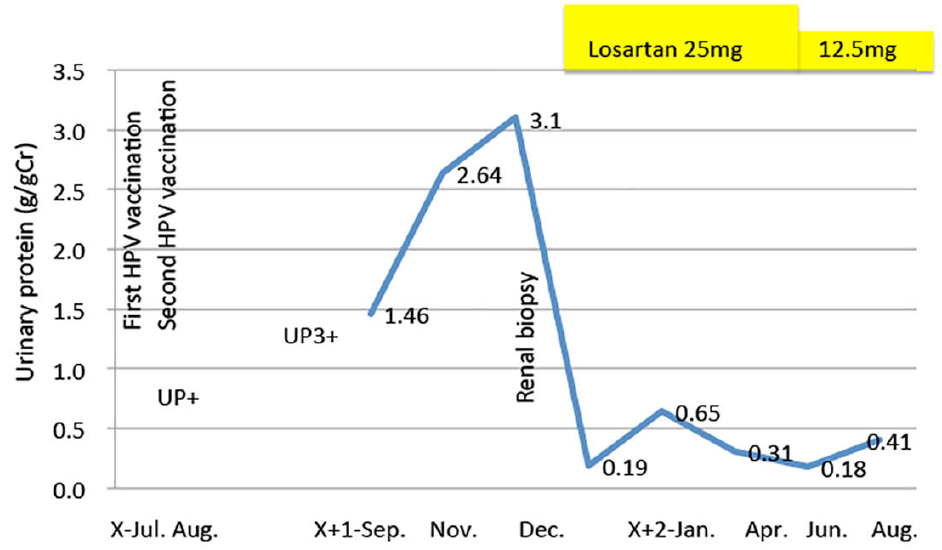
Figure 6. Time course of urinary protein after HPV vaccination and treatment with an angiotensin receptor blocker, losartan, as indicated by the yellow bar.